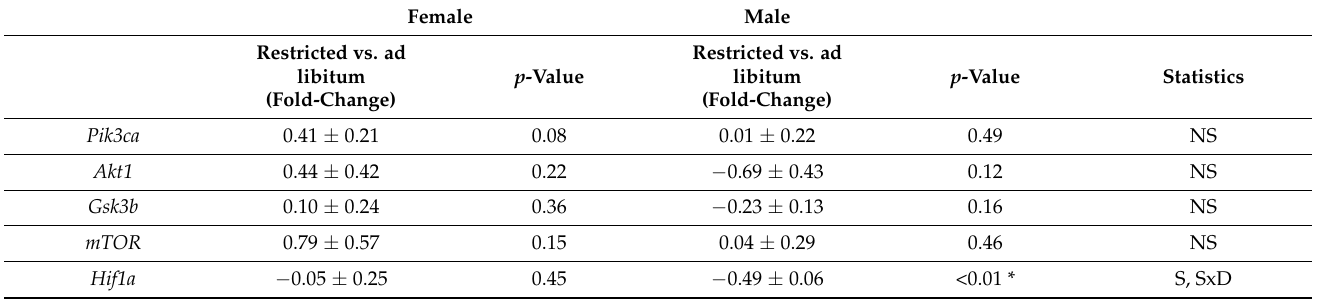
Table 7. mRNA expression levels of key autophagy markers. Two-way ANOVA was performed to assess for significance. S indicates sex effect; SxD indicates interactive effect between sex and diet. NS: non-significant; * Significant differences between calorie-restricted and control groups. Pik3ca : phosphatidylinositol-4,5-bisphosphate 3-kinase, catalytic subunit alpha; Akt1 : AKT serine/threonine kinase 1; Gsk3b : glycogen synthase kinase 3 beta; Mtor : mechanistic target of rapamycin kinase; Hif1a : hypoxia inducible factor 1 subunit alpha.